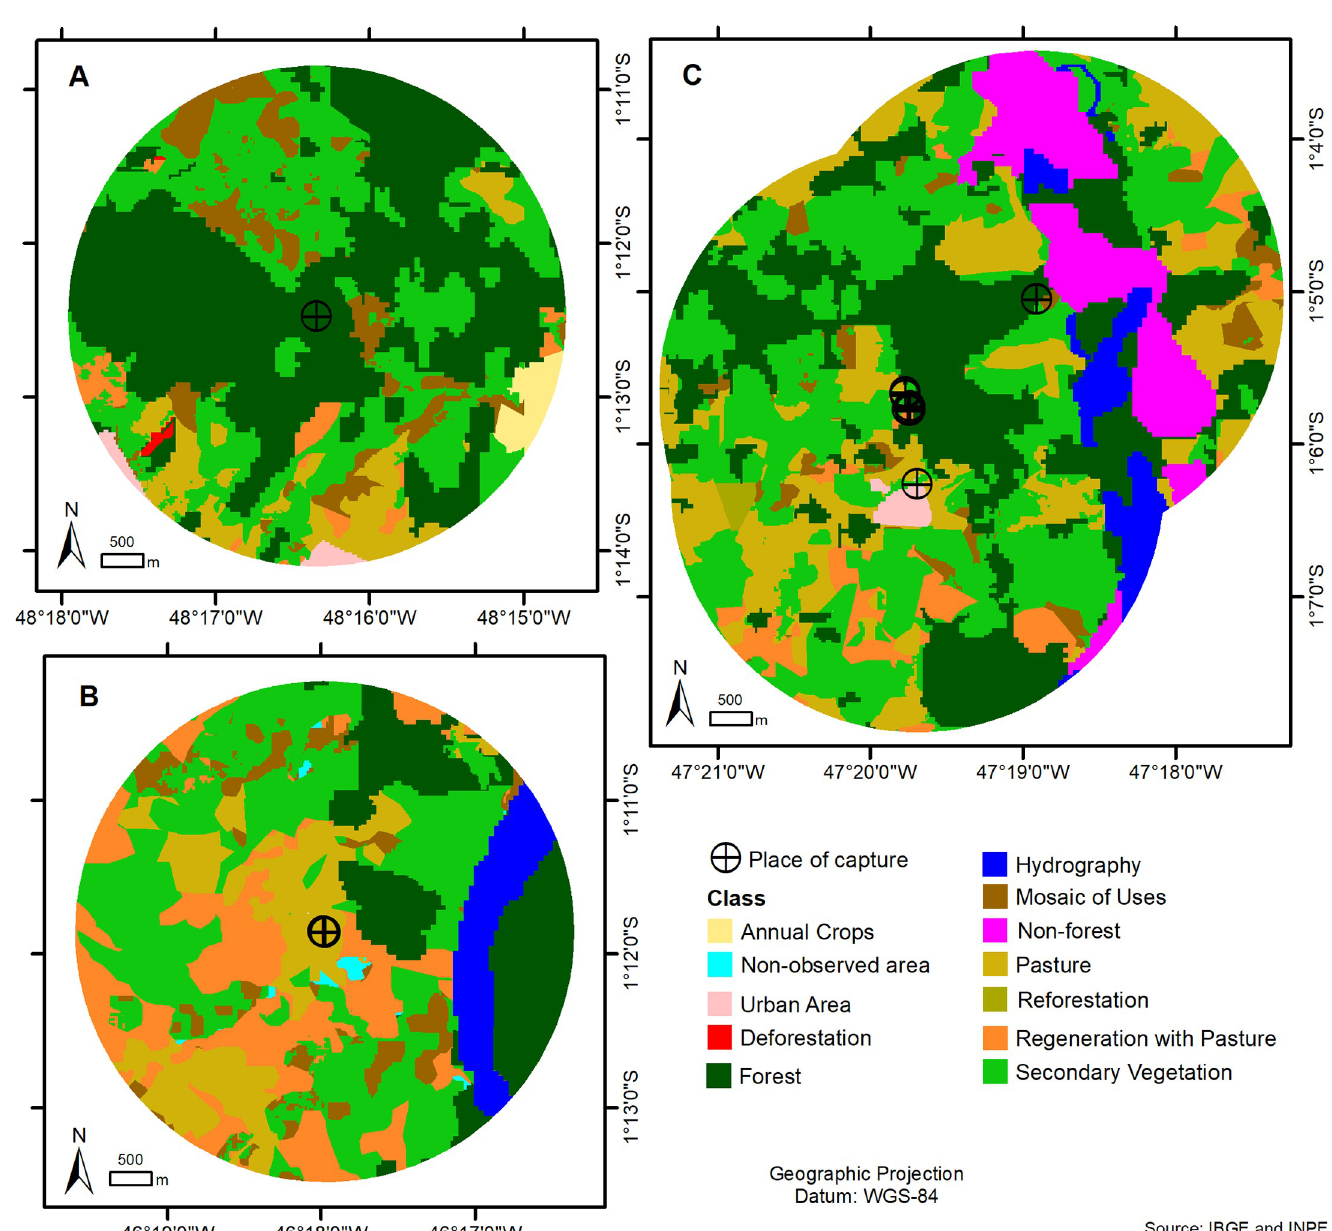
Fig 4. Map of distance of 3 km at the capture sites of the bats in (A) Santa Ba´rbara, (B) Viseu and (C) Peixe-Boi, with land use